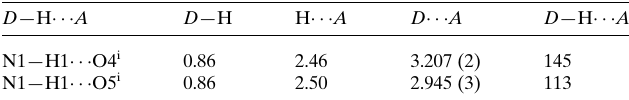
Table 1 Hydrogen-bond geometry (A˚ , (cid:3) ).